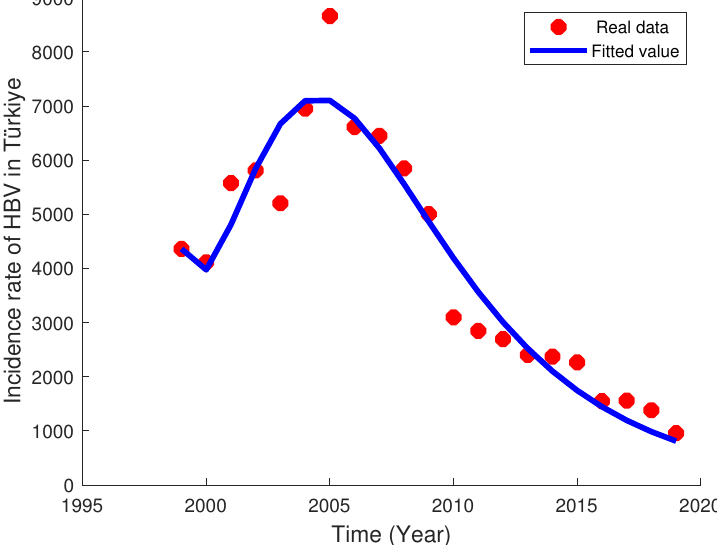
Figure 2. The yearly Hepatitis-B cases time series in Türkiye from 1999 to 2019 and the proposed model’s best-fitted